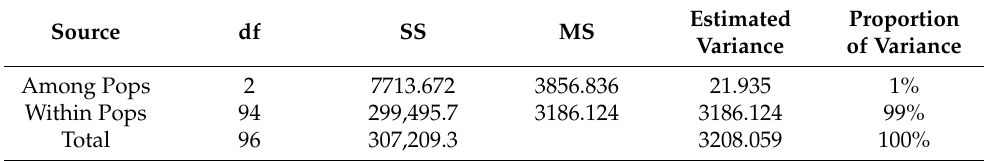
Table 6. Analysis of molecular variance among 97 wheat genotypes genotyped with 16,382 SNP markers .